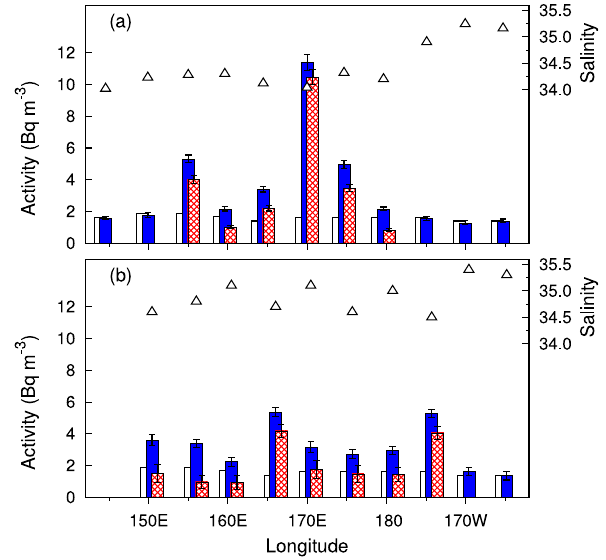
Fig. 3. Activities of 134 Cs (red pattern) and 137 Cs (blue solid) in transect surface seawater samples between Japan and Hawaii from June 2011 (a) and June 2012 (b) . The estimated preexisting 137 Cs activities are drawn by the empty boxes. Activities are decay- corrected to 11 March 2011. Salinity of the samples is shown by